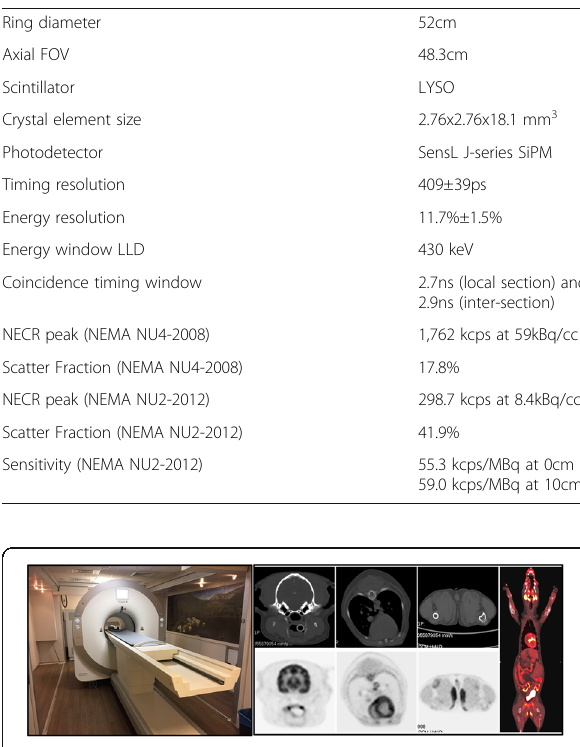
Table 1 (abstract A9). Design and performance parameters for mini EXPLORER II